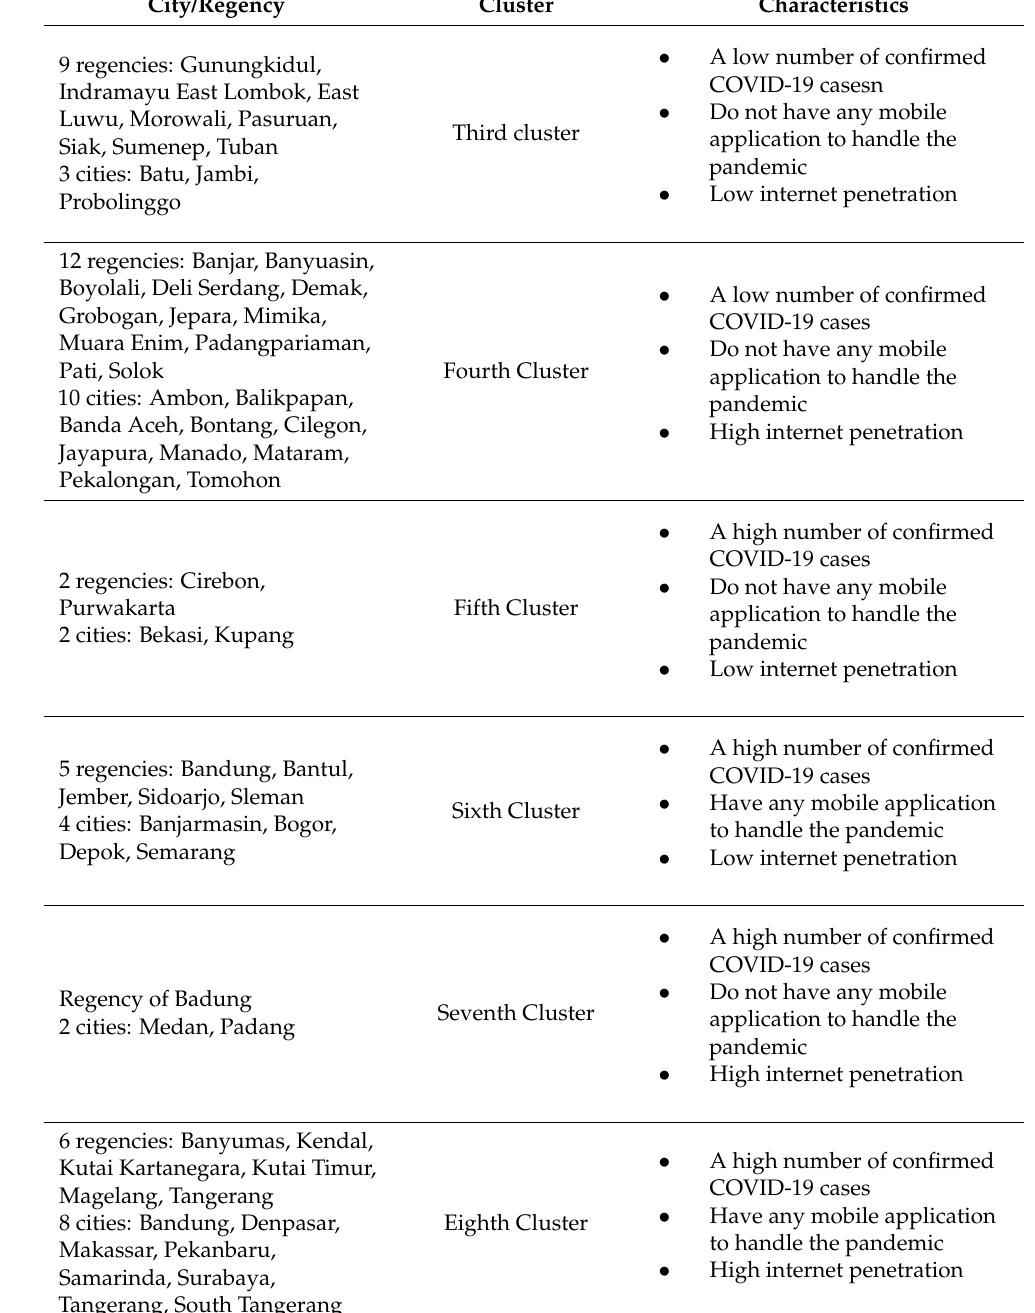
Table 3. Cont. City/Regency Cluster